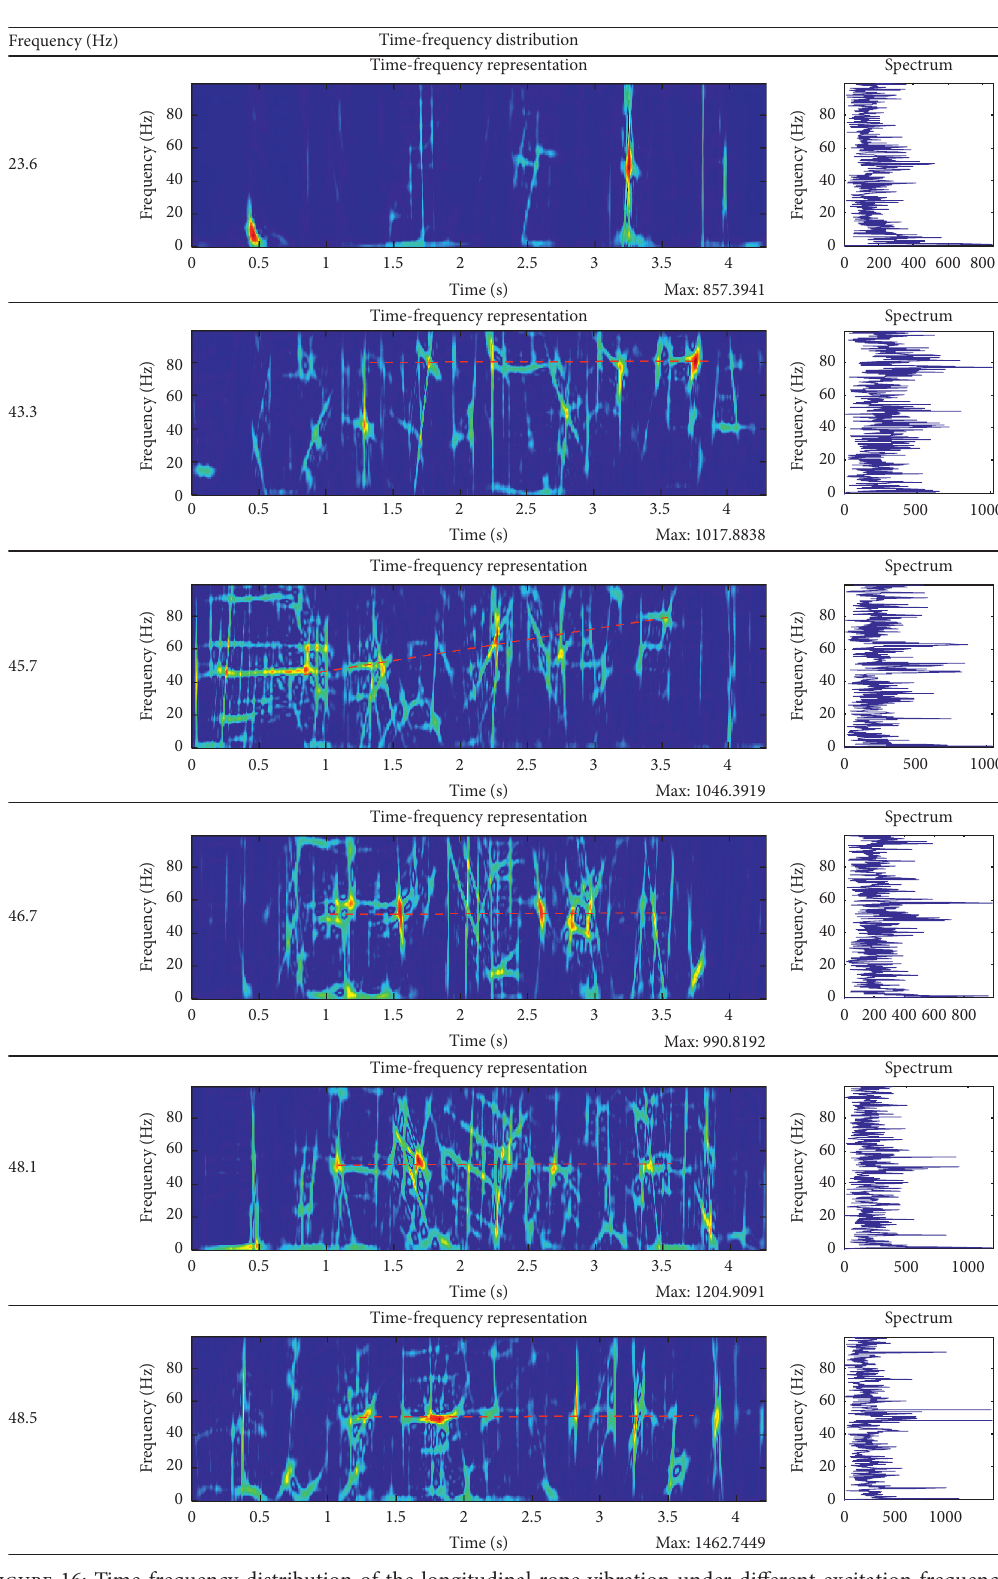
Figure 16: Time-frequency distribution of the longitudinal rope vibration under different excitation explains the phenomenon that the standard deviation of the original static excitation are interlinked after the lifting rope transverse vibration in Figure 15 reaches the maximum motion begins. A significant harmonic wave is formed near when it is excited at 43.3 Hz [24]. 80 Hz in the time-frequency distribution diagram, which